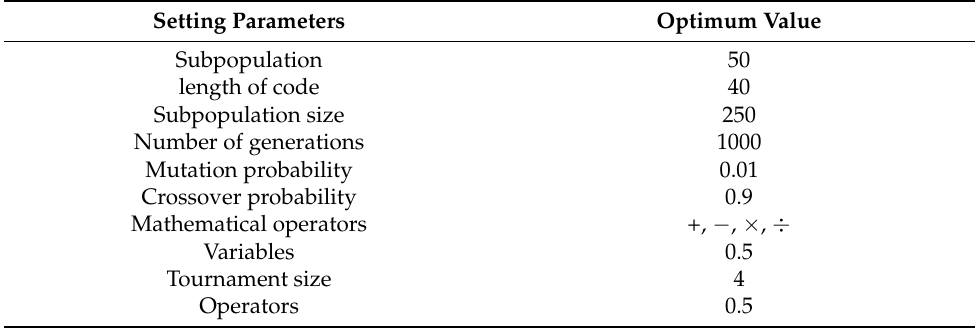
Table 1. Best parameter setting used in MEP modeling.